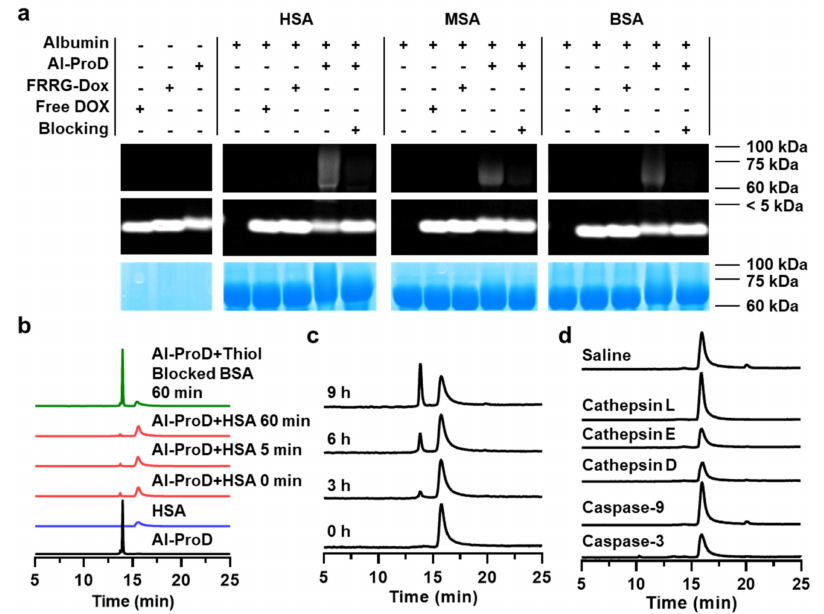
Figure 2. Albumin binding and selective activation of Al-ProD. ( a , b ) Albumin-binding of Al-ProD. Al-ProD was incubated with human serum albumin (HSA), mouse serum albumin (MSA), or bovine serum albumin at room temperature. As a control, the HSA solution was pre-incubated with γ - maleimidobutyric acid to block thiol in HSA. In addition, free DOX or FRRG-DOX with the absence of a maleimide group were also incubated with three types of serum albumin. After incubation, samples were analyzed via ( a ) SDS-PAGE gel and ( b ) RP-HPLC. ( c , d ) HPLC chromatograms when Al-ProD was incubated with ( c ) cathepsin B or ( d ) other